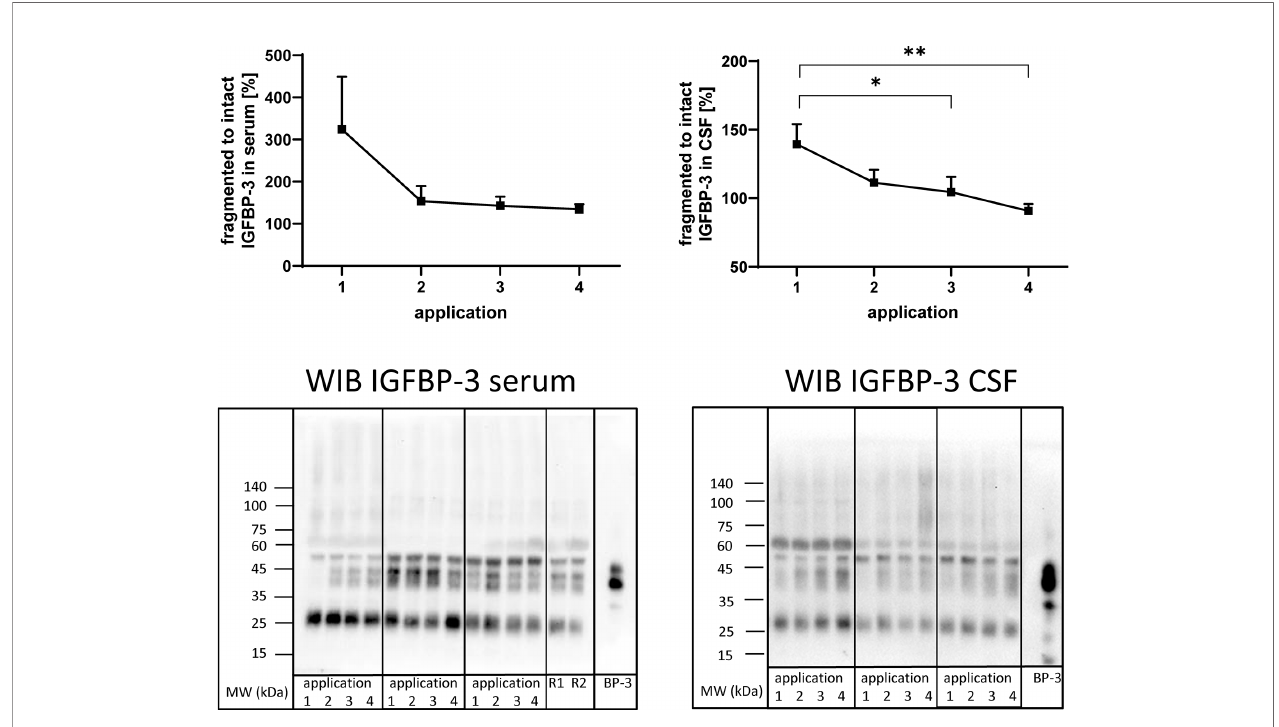
FIGURE 5 | Fragmentation of IGFBP-3 in serum (left panel) and CSF (right panel) from MS patients at the time points of intrathecal TCA application. A subset of samples from 11 treatment cycles (seven cycles in four males and four cycles in two females) was used in this analysis. Fragmentation was calculated by the average ratio of fragmented (25 kDa) versus intact (40 – 43 kDa) IGFBP-3 and is presented in percentages (means ± SEM; *p < 0.05; **p < 0.01). On the lower panels examples for the Western immuno blot (WIB) are provided for the analysis of serum and CSF. All samples from treatment cycles I to IV were loaded on the same gel and recombinant human IGFBP-3 (BP-3) was loaded as the positive control. R1 and R2 represent technical replicate samples for normalization of different